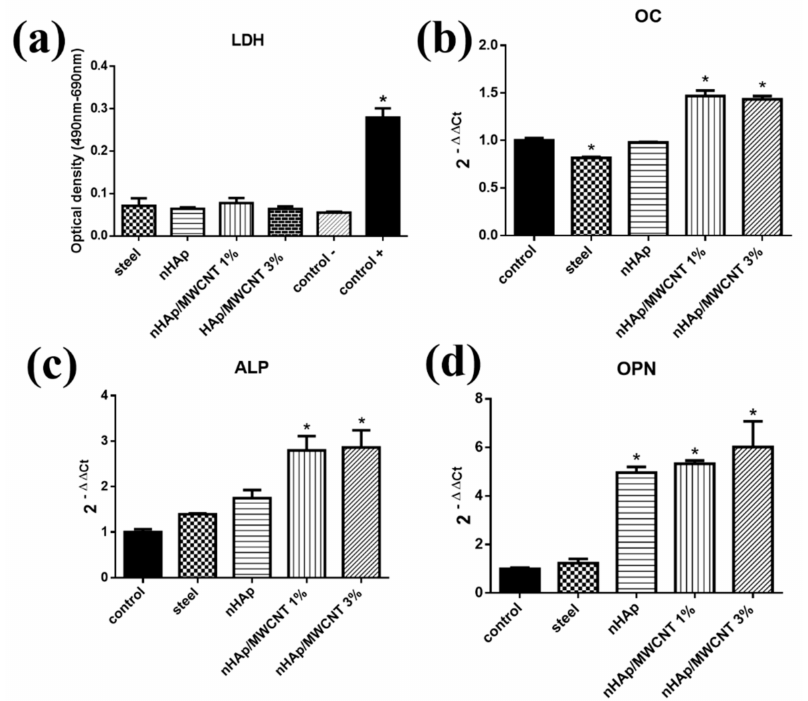
Figure 3. ( a ) Cell viability assay performed by the lactate dehydrogenase (LDH) assay to analyze different groups (316L stainless steel, nHAp, nHAp/MWCNT 1% and nHAp/MWCNT 3%). The control group ( − ) represents the negative control for cell death, while the control group (+) in which DMSO was added, represents the positive control for cell death. All groups were matched